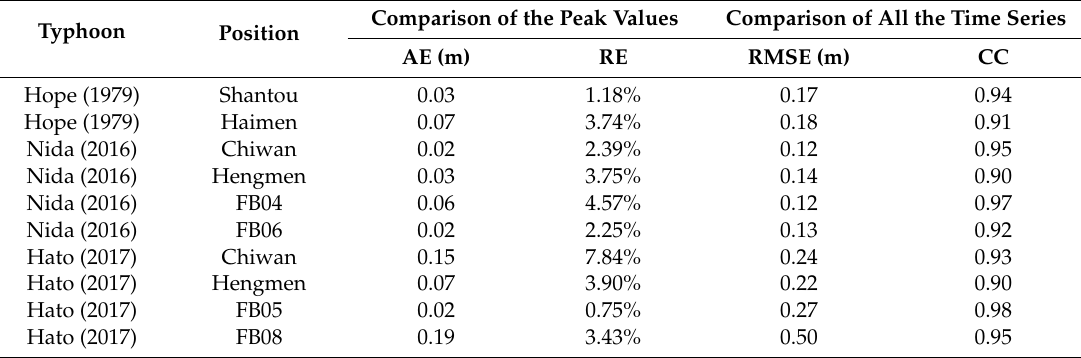
Table 2. Indices used to assess the simulation results of the storm surges and significant wave